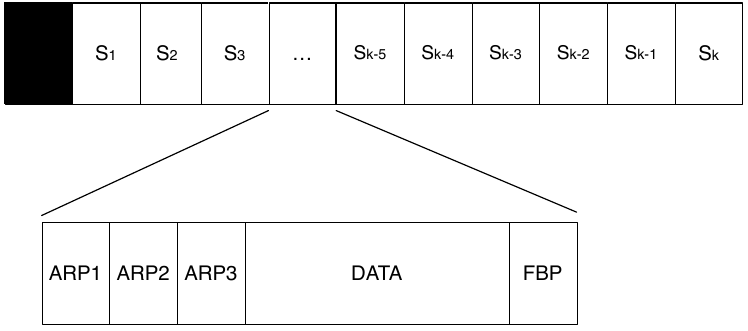
Figure 2. Distributed Queuing (DQ) time organization. The black square in front of the first slots represents the protocol used to wake-up and synchronize the